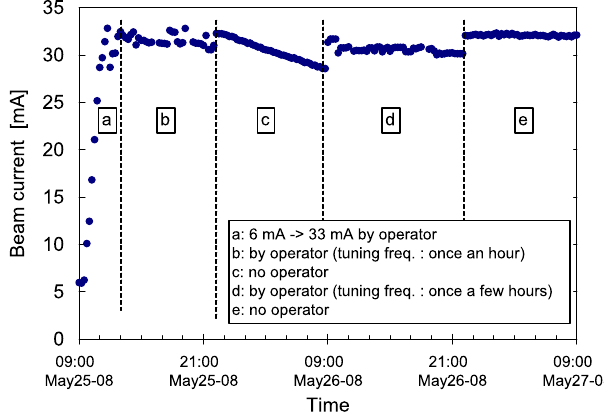
FIG. 12. (Color) Example of change in beam current when mode is changed from low to high